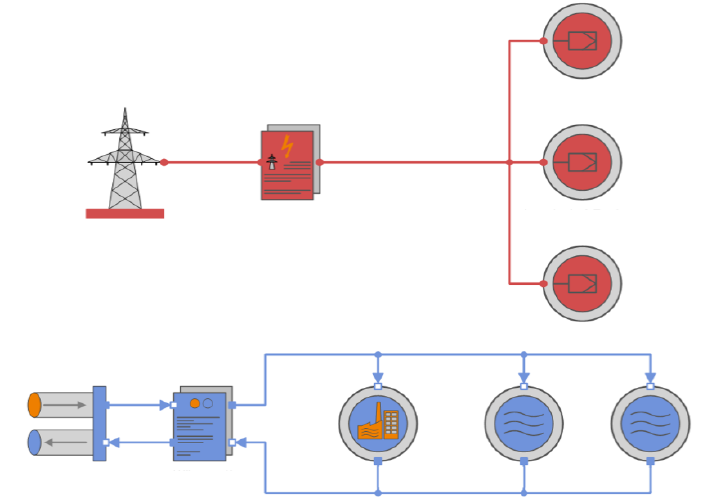
Figure 6. Model of the islands energy system’s actual state